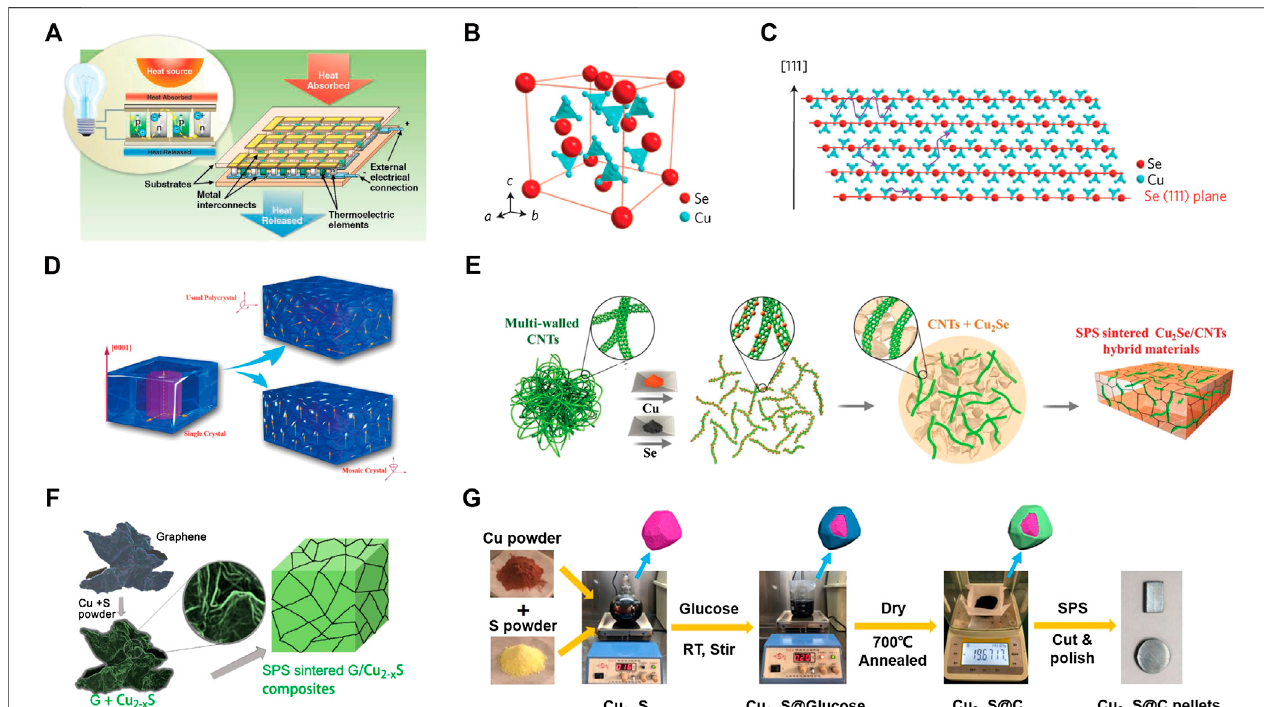
Figure 1 | (A) A thermoelectric generator module and heat drives (inset). Reproduced with permission (Service, 2004). Copyright 2004, American Association for the Advancement of Science. (B) Unit cell of cubic Cu 2 Se. (C) Projected plane representation of the crystal structure along the cubic [1 − 1 0] direction. The arrows indicate that the Cu ions can freely travel among the interstitial sites. Reproduced with permission (Liu et al., 2012). Copyright 2012, Nature Publication Group. (D) Structural characteristics of a single crystal, a usual polycrystal, and a mosaic crystal. Arrows refer to alignment of crystal grains. Reproduced with